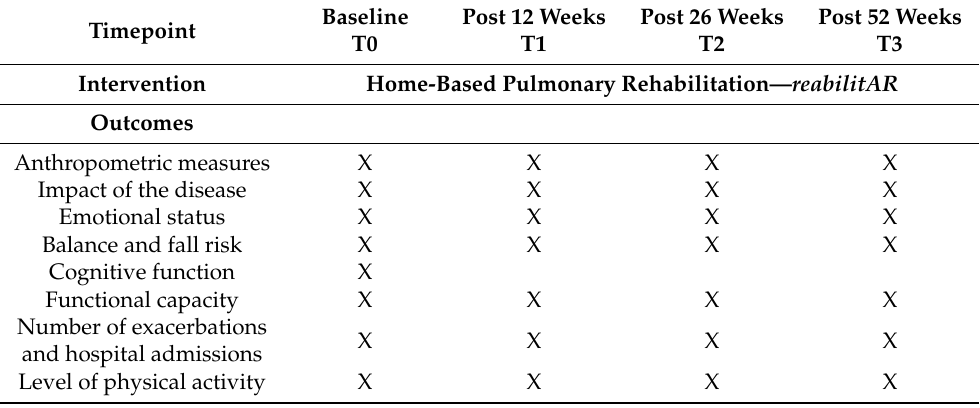
Table 1. Outcomes assessed in each time point of the reabilitAR